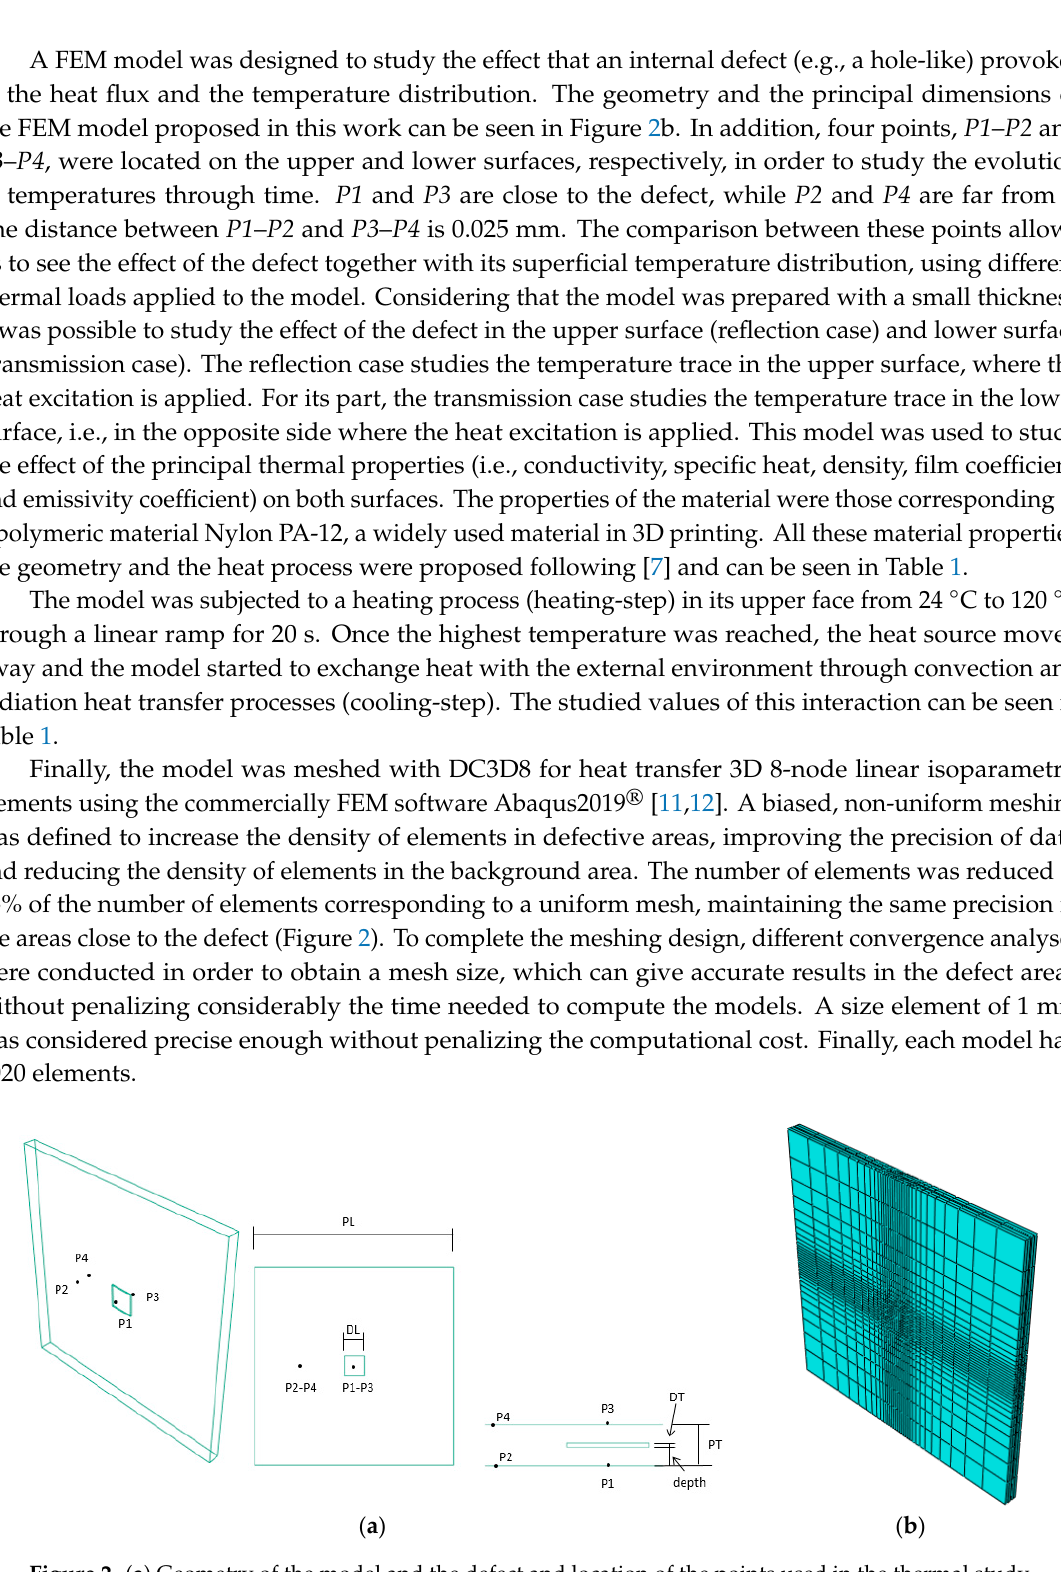
Figure 2. ( a ) Geometry of the model and the defect and location of the points used in the thermal study. ( b ) Biased mesh with greater mesh density close to the defect area. PL and DL refer to the length of the plate and defect, respectively, being PL = 0.1 m and DL = 0.01 m, whereas PT and DT refer to the thickness of the plate and defect, respectively, being PT = 0.005 m and DT = 0.0005 m. Several command lines were added, using Python language to the file created by Abaqus. These command lines were programmed to obtain temporal evolutions of the temperatures in points P1 to P4 . More command lines were used to plot contrast curves based on temperature versustime between points P1 – P2 and P3 – P4 . The higher this contrast, the easier it is to detect a defect, as well as its size and location.